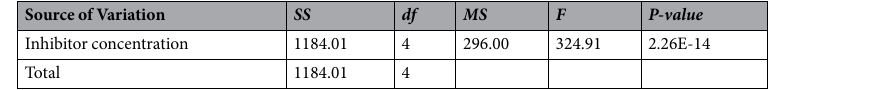
Table 5. ANOVA for inhibition efficiency of l-Proline in 1M HCl (at 95% confidence level).